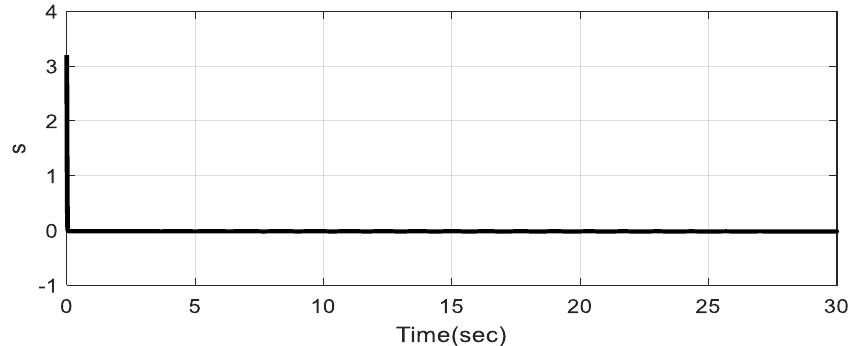
Figure 3. Time histories of the nonlinear sliding surface.